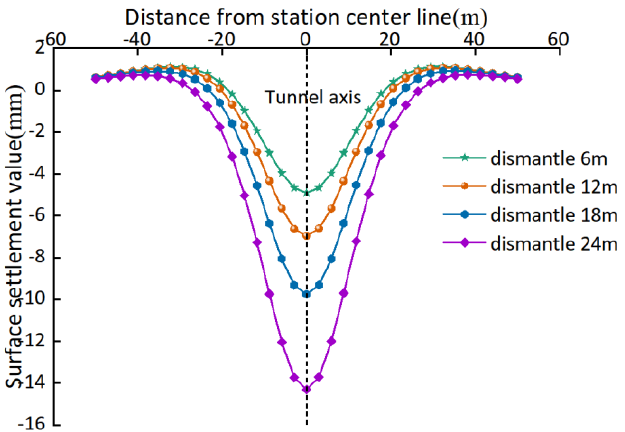
Figure 10. Surface settlement curve.